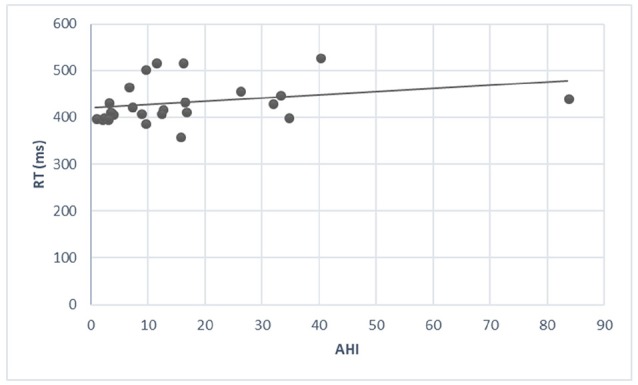
There is a modest increase in RT when AHI increases. The correlation coefficient reaches a significant level (r = 0.29, P < 5%).